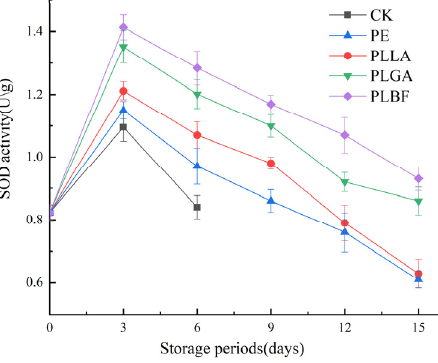
Figure 11. Changes of SOD activity of Agaricus bisporus in each packing group during storage.